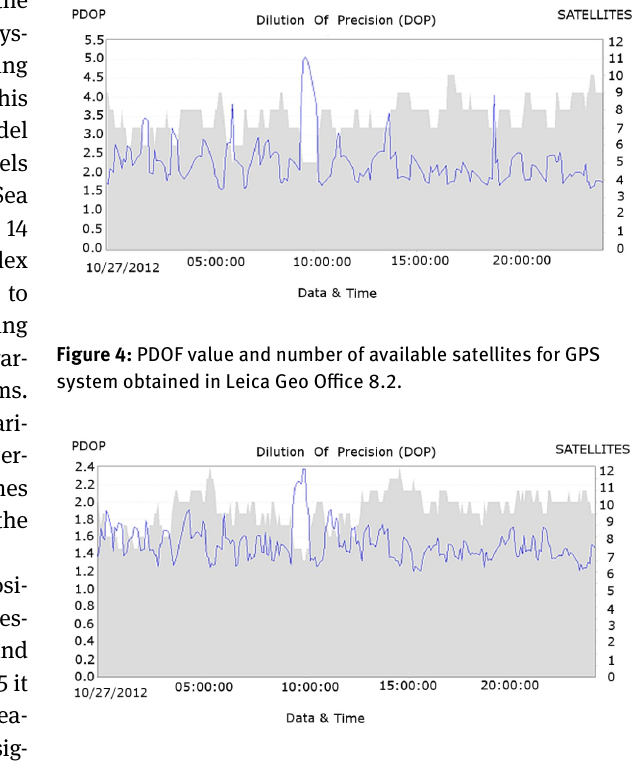
Figure 5: PDOF value and number of available satellites for GPS/GLONASS systems obtained in Leica Geo Oflce 8.2.